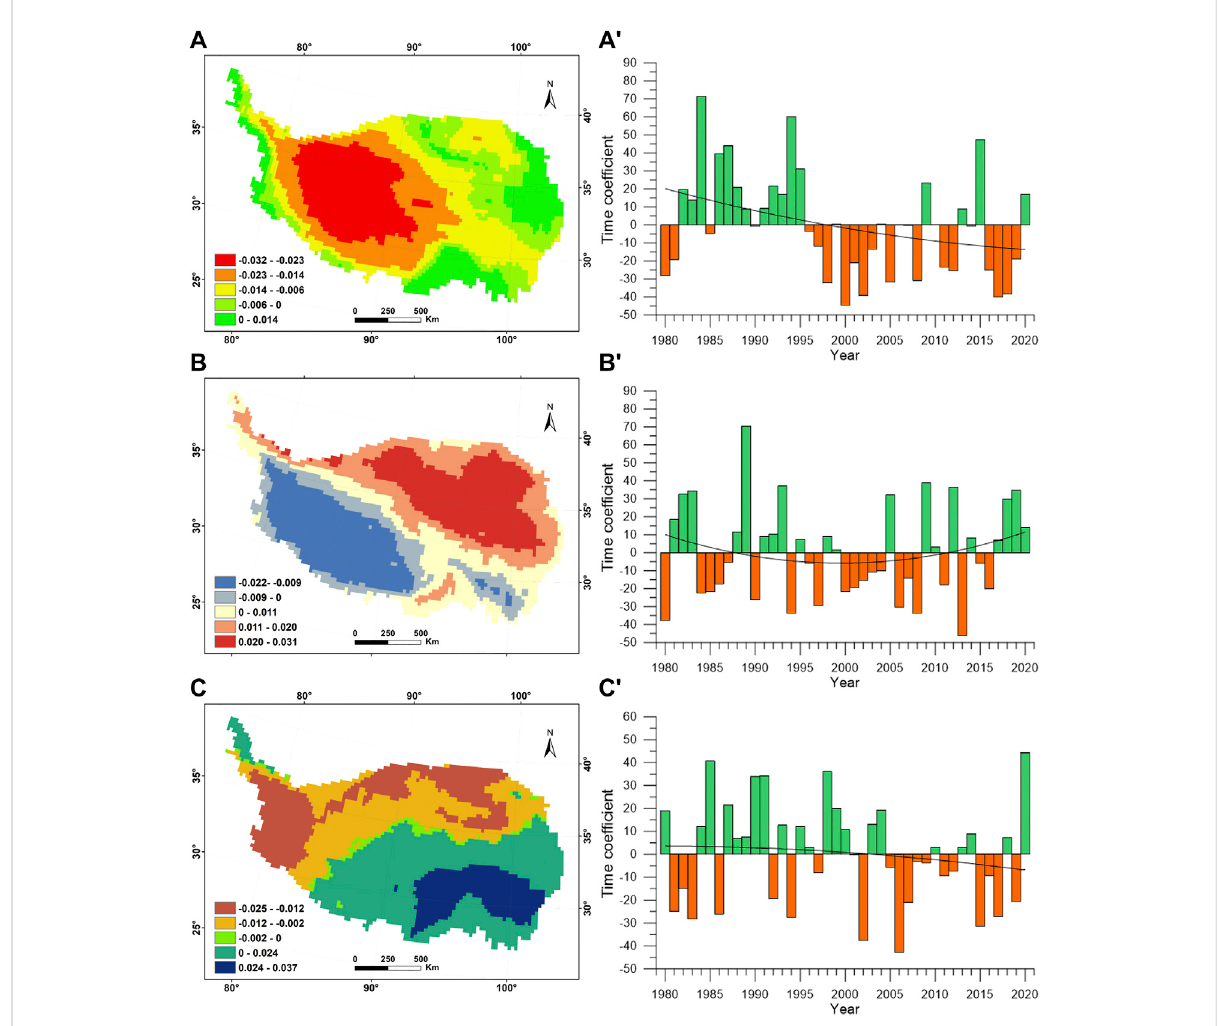
FIGURE 7 Spatial gathering distribution and time coef fi cients. (A,A ’ ) EOF mode1, (B,B ’ ) EOF mode2, (C,C ’ ) EOF